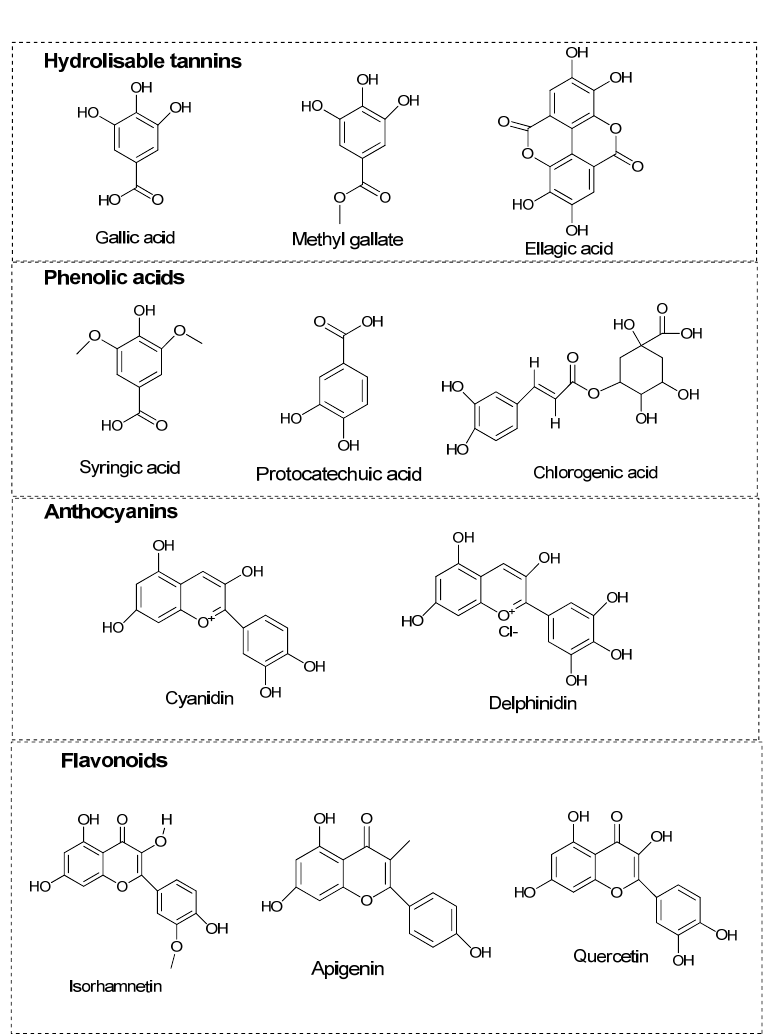
Figure 4. Structures of selected polyphenolic compounds in Rhus coriaria L.